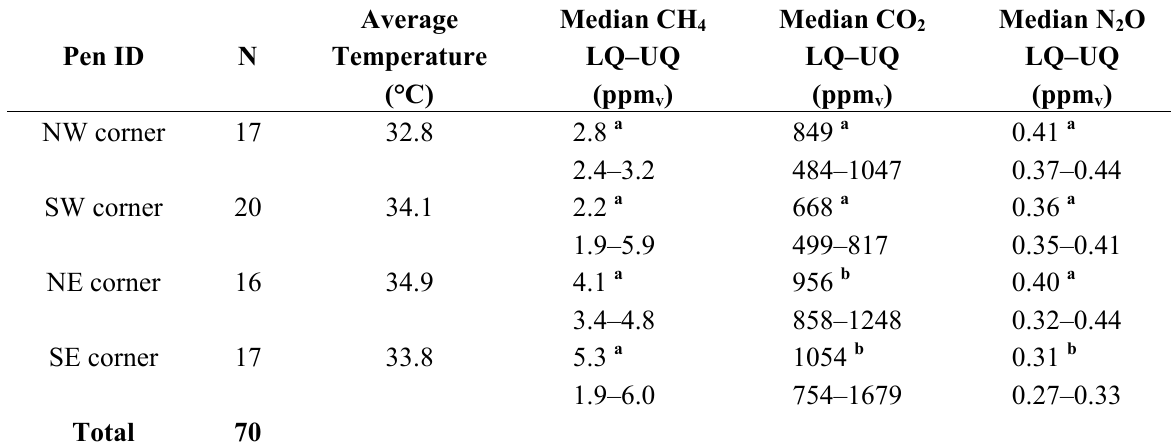
Table 4a. Volumetric concentration (median and quartiles) GHGs measured from various pens at a